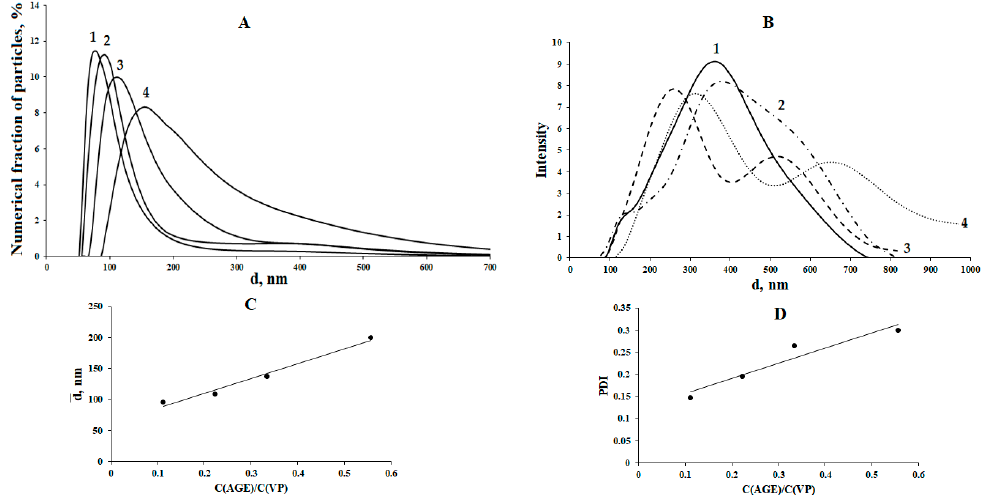
Figure 6. Plots of size vs. chain composition. ( A ) Number distributions of the aggregate diameters for different VP/AGE molar ratios: (1) − 9; (2) − 4.5; (3) − 3; (4) − 1.8. ( B ) Intensity distributions of the aggregate diameters. ( C ) Number-average particle diameter as a function of VP/AGE ratio. ( D ) PDI as a function of VP/AGE ratio.